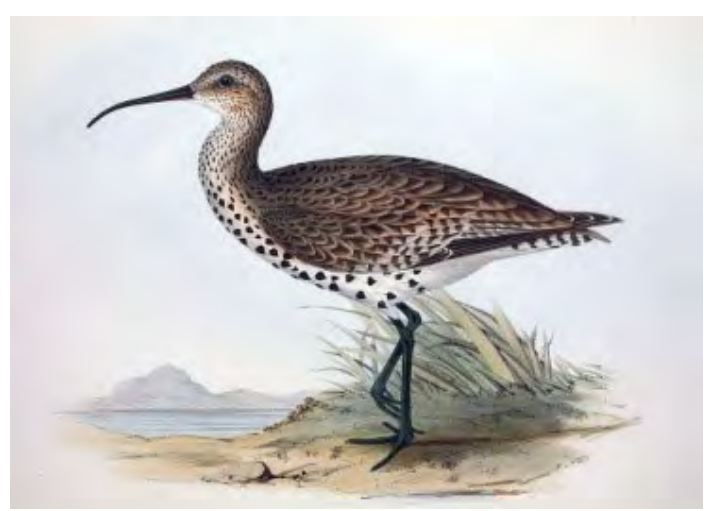
Figure 1. The very rare Slender-billed Curlew. Libya. [5]. p6